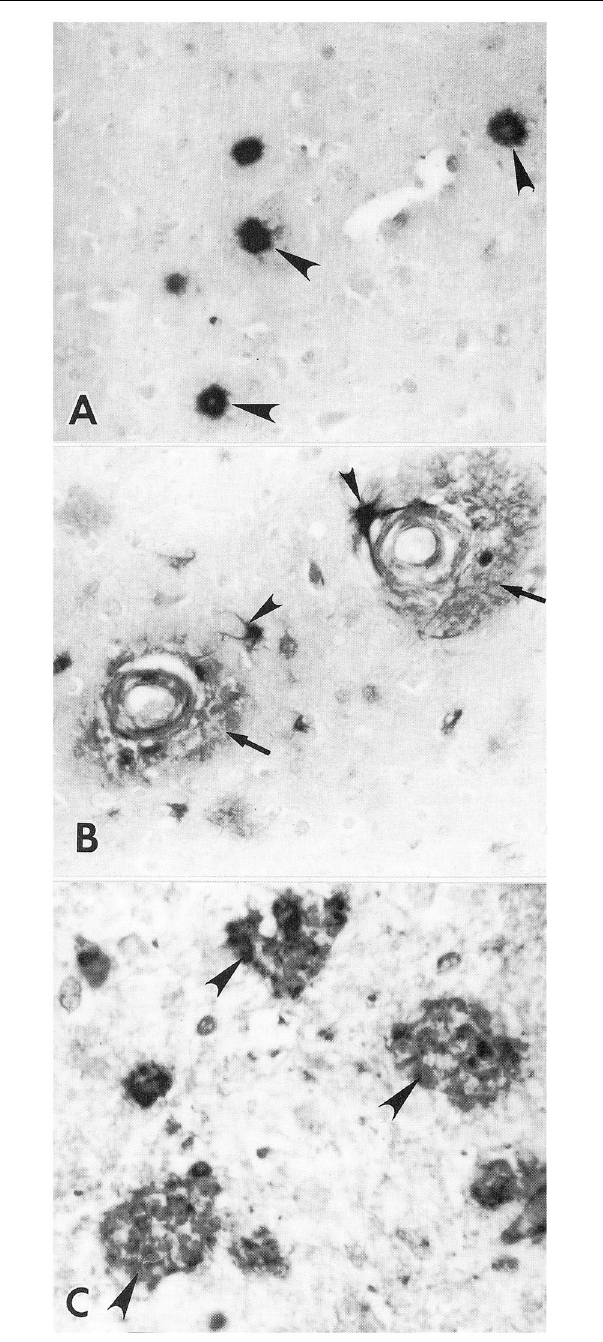
FIGURE 4 | Immunolocalization of HSPG core protein in AD brain. (A) Positive immunostaining of plaque amyloid (arrowheads) with a monoclonal antibody (HK-102) to the core protein of HSPGs in a 72-year old man with AD. Original mag. × 276. (B) Positive anti-HSPG immunostaining of cerebrovascular amyloid deposits (arrows) in AD brain of a 92-year old female patient. Note positive staining of adjacent astrocytes (arrowheads) Original mag. × 276. (C) Positive immunostaining of primitive plaques (arrowheads) with anti-HSPG polyclonal antibody in a 92-year old female patient with AD. Original mag. × 616 (Snow and Wight,